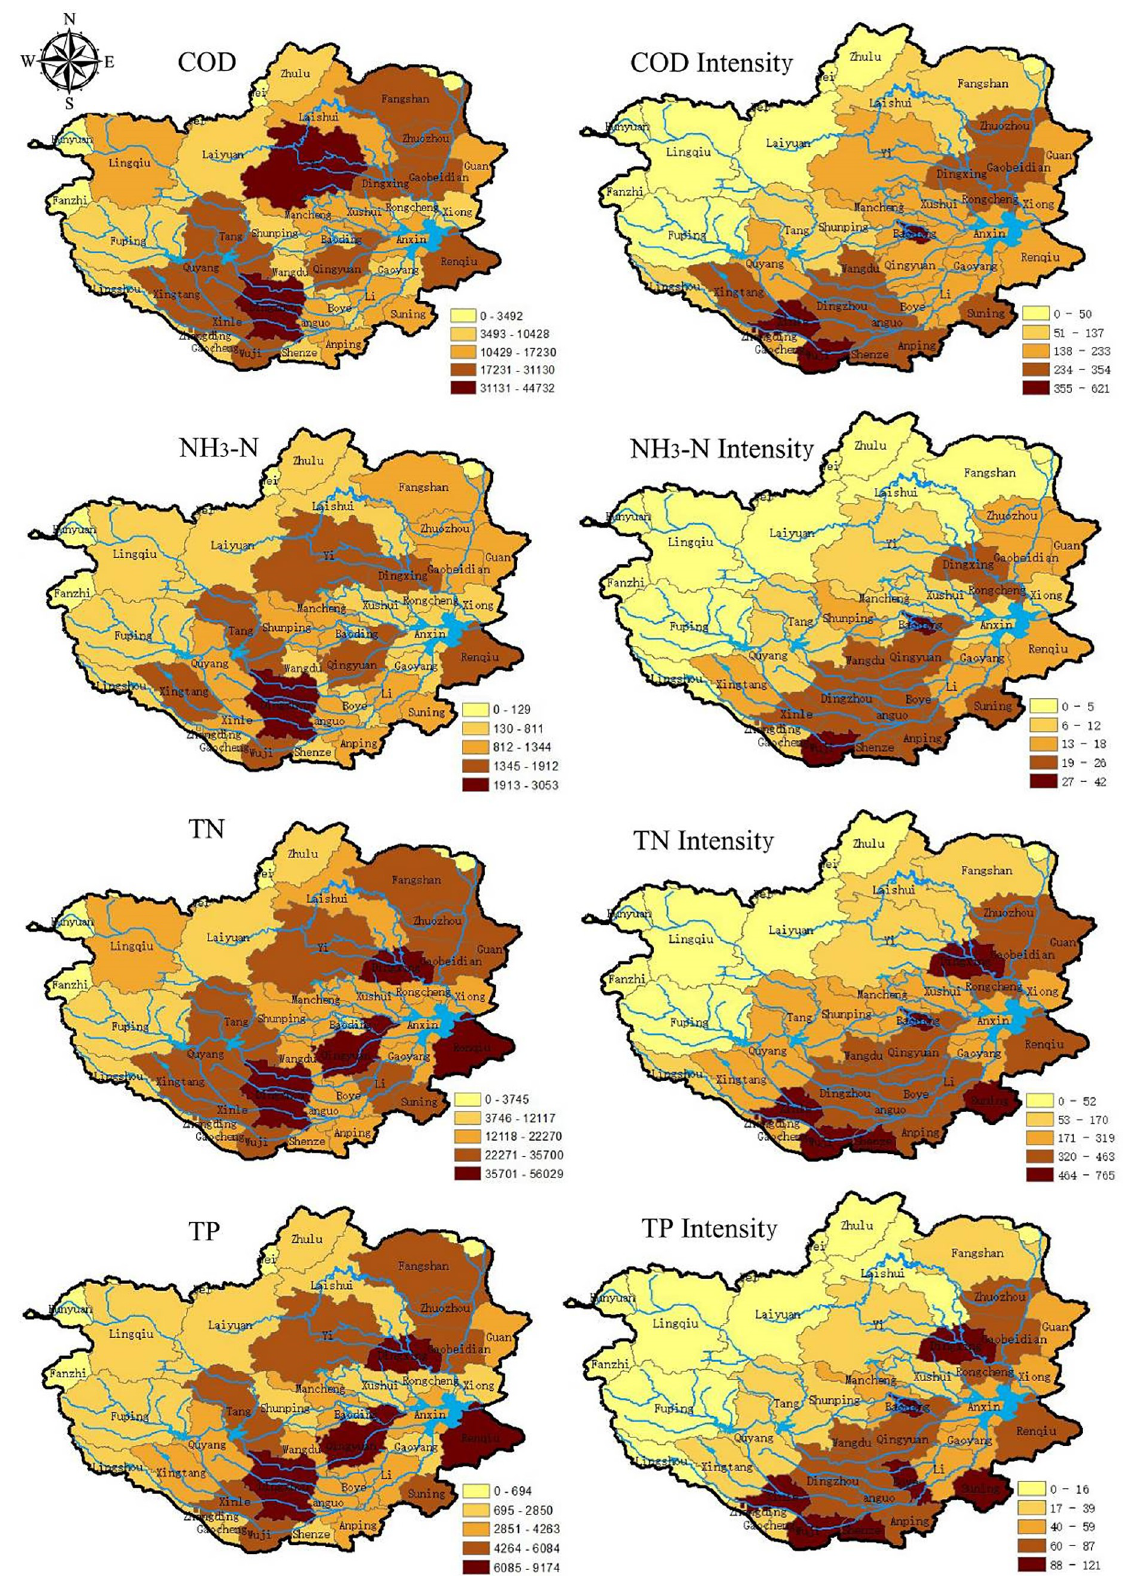
Fig 4. Spatial distribution of total potential pollution (Mg) and intensities in the Baiyangdian Basin (kg/ha). https://doi.org/10.1371/journal.pone.0239006.g004 PLOS ONE | https://doi.org/10.1371/journal.pone.0239006 September 22,